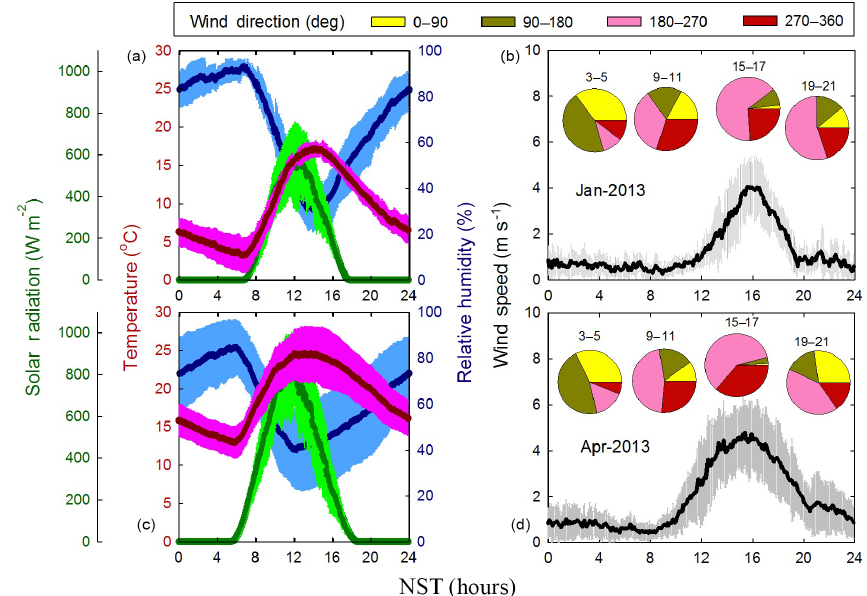
Figure 3. Average diurnal variations in temperature, solar radiation, relative humidity, wind speed and direction at Bode during January (a, b) and April 2013 (c, d) . These two months are taken as representative for winter and spring, respectively. (b, d) Wind directions during four time periods (03:00–05:00, 09:00–11:00, 15:00–17:00 and 19:00–21:00h) are shown as pie charts in wind speed